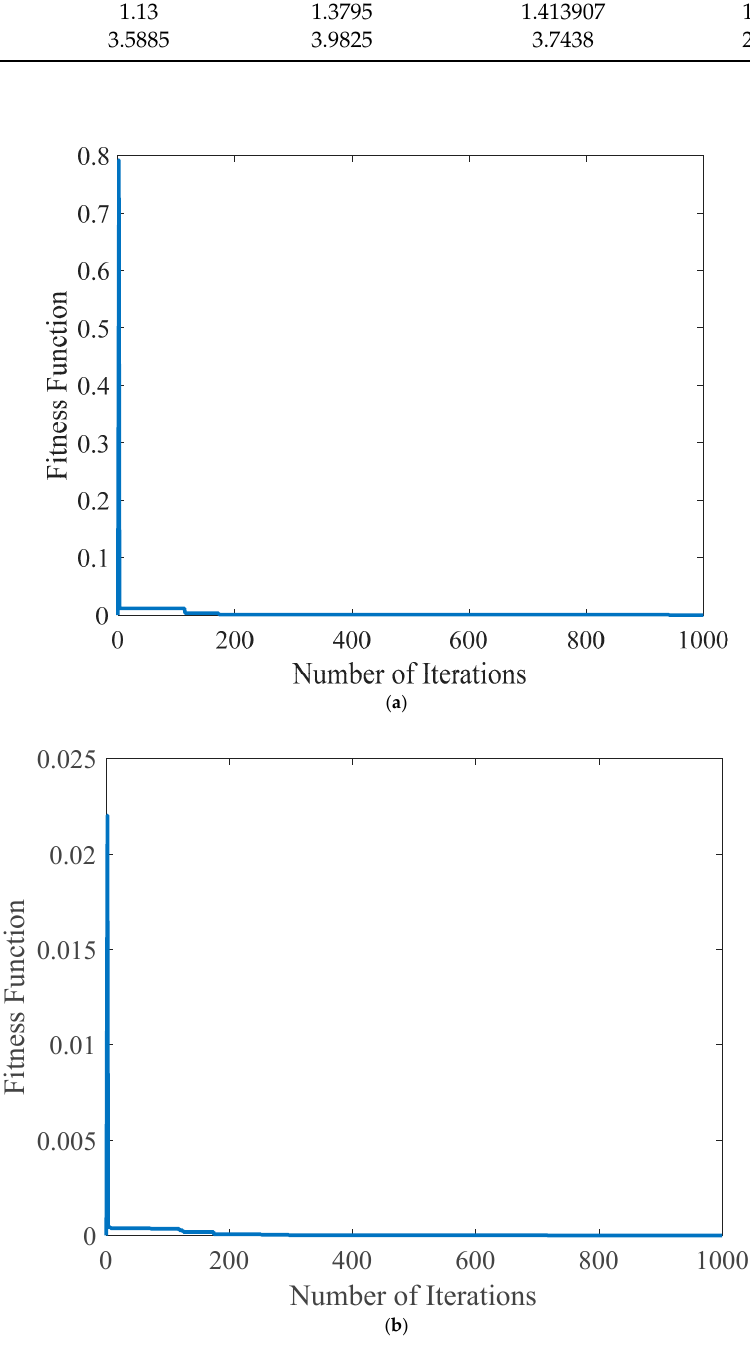
Figure 3. Objective function convergence. ( a ) KC200GT; ( b ) MSX60.